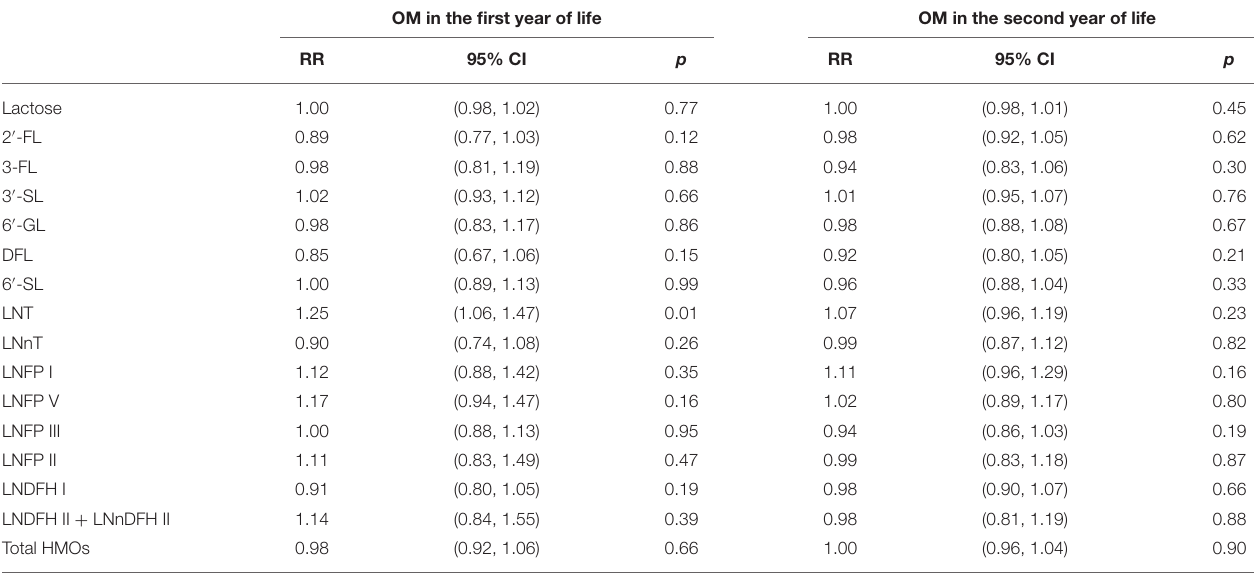
TABLE 5 | Adjusted associations between human milk oligosaccharides in secretor milk measured at 6 weeks of lactation with otitis media in the first or second year of life in the Ulm SPATZ Health Study. OM in the first year of life OM in the second year of life RR 95% CI p RR 95% CI p Lactose 1.00 (0.98, 1.02) 0.77